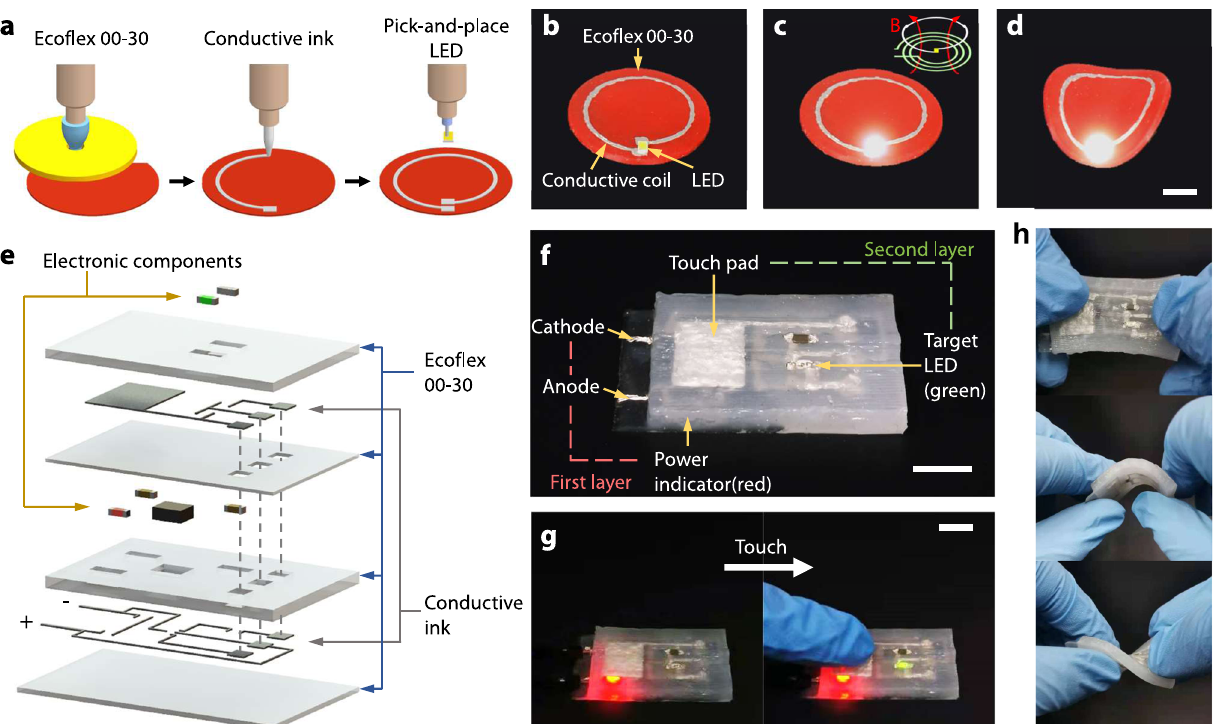
Fig. 6 | Demonstration of hybrid 3D printing of soft electronics. a Schematic illustration of printing a conductive coil with pick-and-place LED on Eco fl ex 00-30 substrate. b Imageoftheconductivecoilwithpick-and-placeLEDonEco fl ex00-30 substrate. c The LEDlight can be turnedon by analternating magnetic fi eld. d The LEDlightkeepsonwhentheEco fl exsubstrateisbent. e Schematicdesignofamulti-